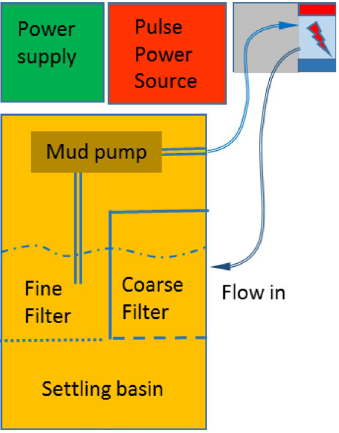
Fig. 20 Schematic of filtering